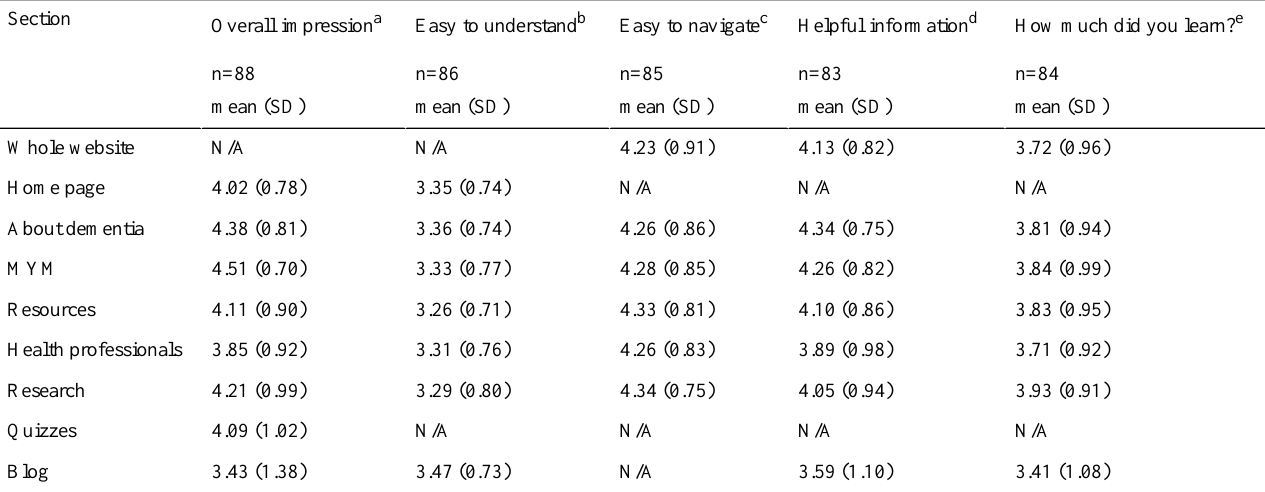
Table 5. Mean (SD) ratings for questions asked in relation to website sections.